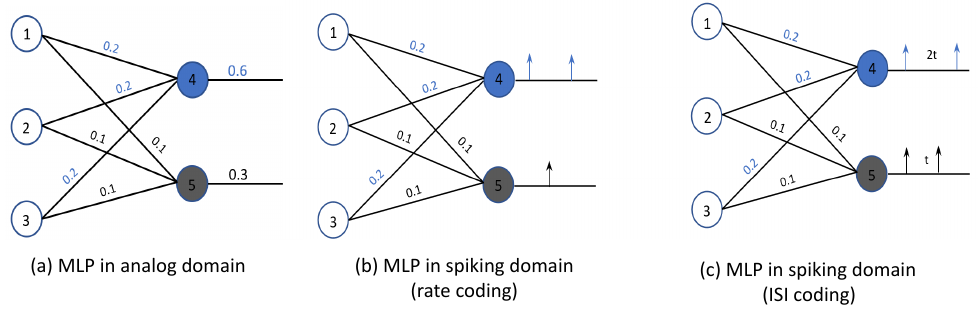
Figure 9. Example of converting an analog MLP to its spiking equivalent.